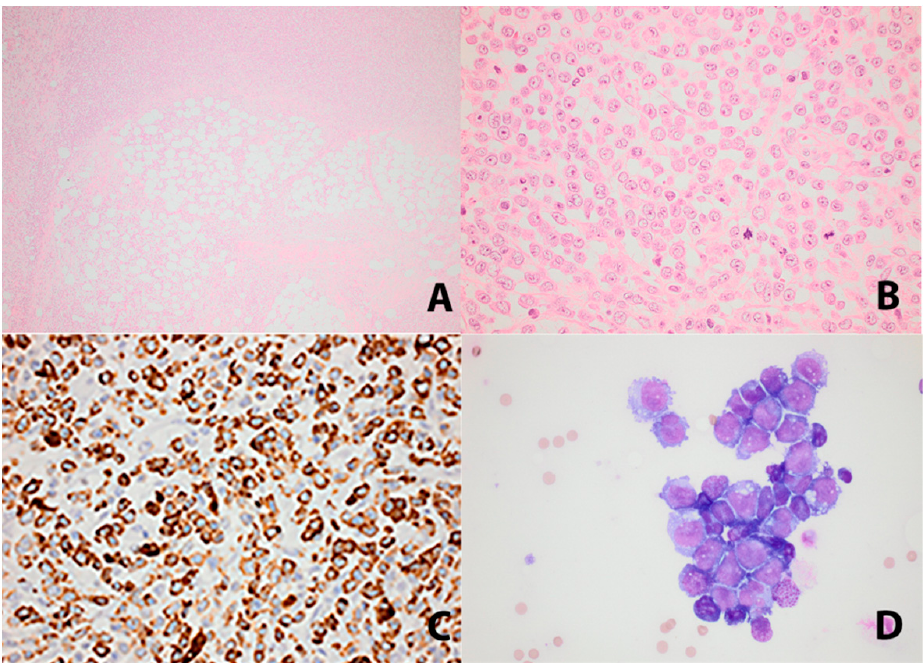
Figure 2. Histopathology of omental infiltrate and ascitic fluid: ( A ) Omental fatty tissue with diffuse infiltration of tumor cells (HE × 4). ( B ) The tumor cells were large with vesicular nuclei. Frequent mitoses were seen (HE × 40). ( C ) CD68PGM1 showing characteristic granular cytoplasmic staining ( × 40). ( D ) Cytomorphology of the tumor cells in ascitic fluid ( × 40). A histopathological examination of the resected tissue from the omentum demonstrated a dense and diffuse infiltration of the fatty tissue by large mononuclear cells with large vesicular nuclei with eosinophilic nucleoli. The cytoplasm was eosinophilic with some vacuolization. The cells were of a hematological origin and expressed CD45. They had a fully developed histiocytic differentiation profile with an immunohistochemical expression of CD68, CD163, CD4, CD56 and lysozyme and showed a high proliferative rate that in areas reached 50% (Ki-67). The precursor cell, dendritic cell, melanocytic, neuroendocrine cell, B-cell, T-cell and Langerhans cell markers were negative. No BRAF-mutation could be demonstrated. The PD-L1 was negative. Next generation sequencing (NGS) could not demonstrate any fusions. The NGS panel used was ‘Archers FusionPlex Lymphoma’, investigating the mutation, expression and fusion of 125 genes. Ascitic fluid cytology revealed malignant cells with the same phenotype as the tumor tissue in the omentum. The findings were most compatible with histiocytic sarcoma (HS). A differential diagnosis could be monoblastic leukemia, which was excluded on the examination of bone marrow biopsies. It took 24 days from initial hospitalization until diagnosis, which was confirmed by an expert second opinion. The following day the patient was transferred to a specialized hematological department at a tertiary